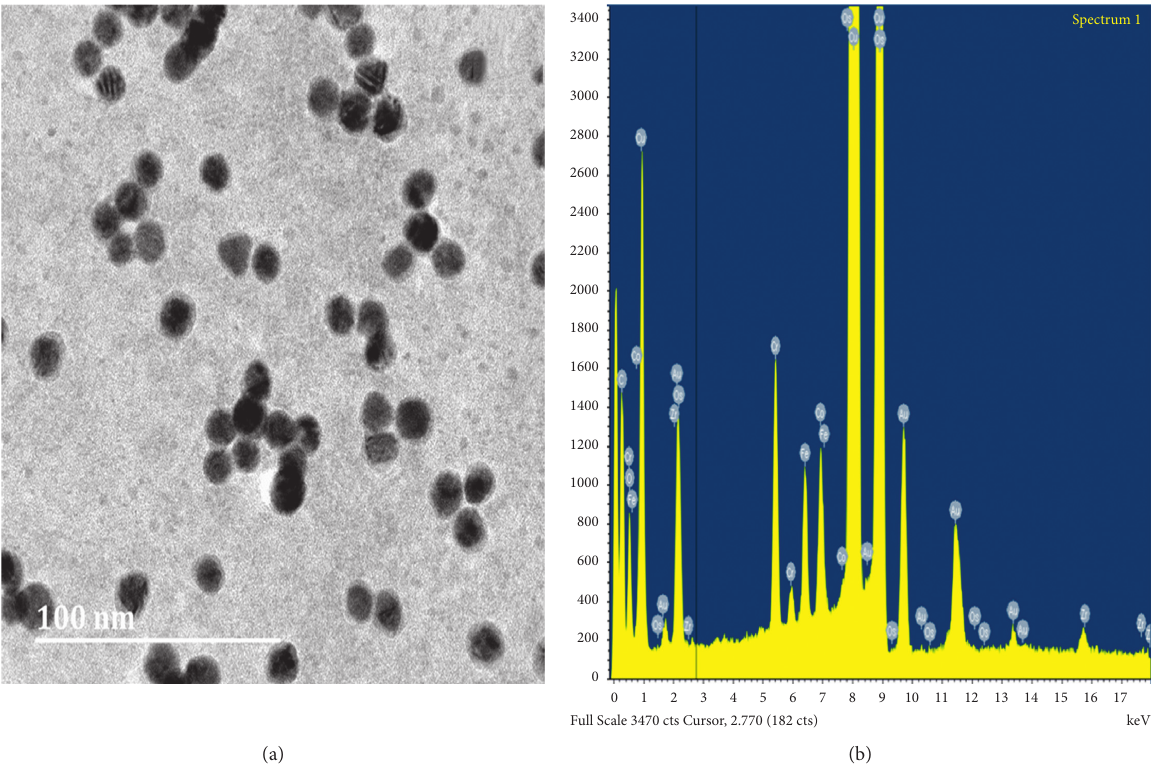
Figure 4: (a) TEM images of chemically synthesized gold nanoparticles and (b) EDX